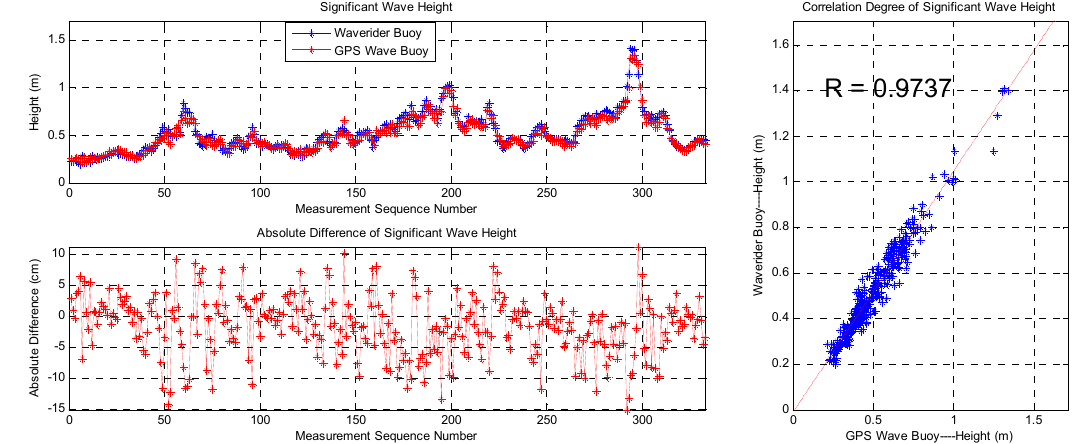
Table 2. Comparison of results between the SBF7-1A GPS wave buoy and the DWR-MKIII Waverider buoy after correction.